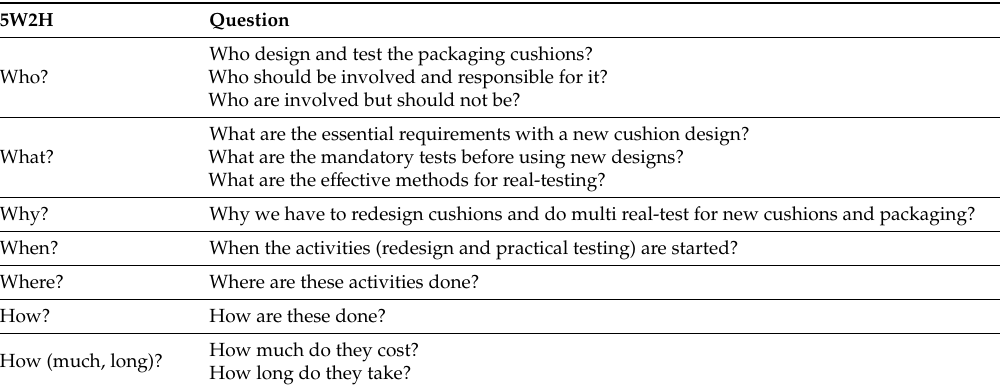
Table 3. 5W2H (five W’s two H’s) example.